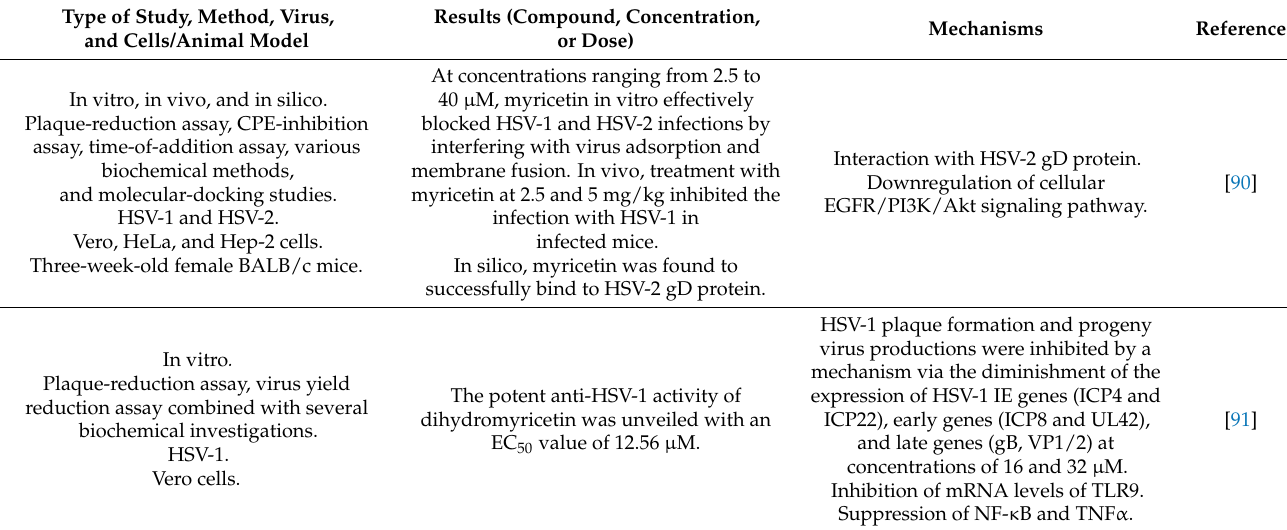
Table 1. Antiviral properties of flavonoids against alpha-herpesviruses (herpes simplex virus (type 1 and type 2) and varicella-zoster virus) with diverse mechanisms of